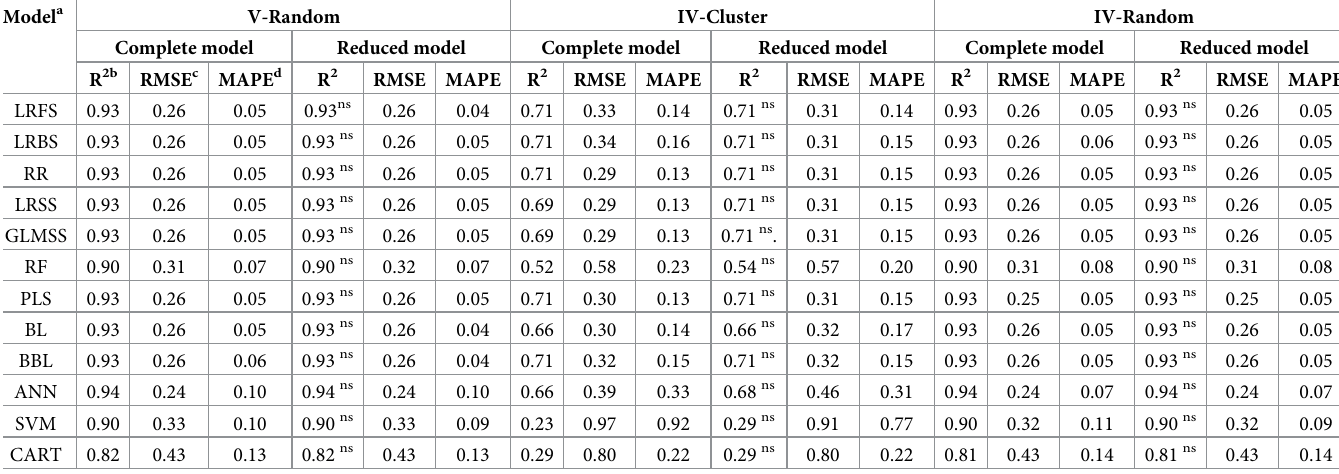
Table 1. Performance of different prediction models for total carotenoid content in cassava roots using colorimetric indices obtained from digital images consider- ing the complete model (all variables) and reduced model (variables with more than 50% relative importance), using the random cross-validation without test set (V-Random), PCA clustering-based cross-validation (IV-Cluster), and random cross-validation with test set